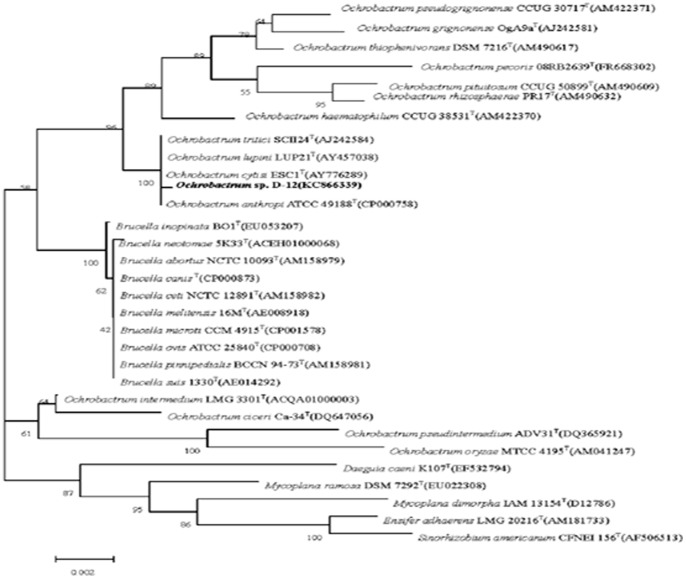
Phylogenetic tree constructed by the neighbor-joining method based on 16S rRNA gene sequences of D-12 and type strains of Ochrobactrum species.Bootstrap values, expressed as percentages of 1,000 replications, are given at branching points. Bar, 0.002 nucleotide substitutions per nucleotide position.